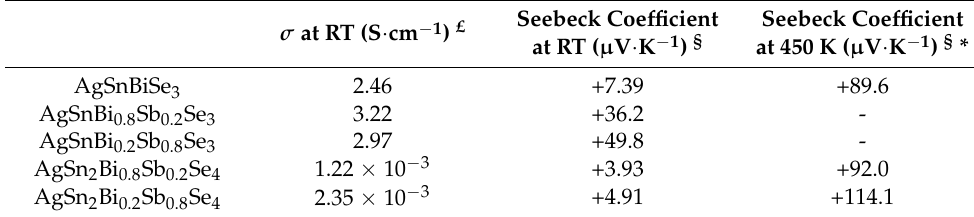
Electrical conductivity ( σ ) and Seebeck coefficient of AgSn[Bi 1 − x Sb x ]Se 3 and AgSn 2 [Bi 1 − x Sb x ]Se 4